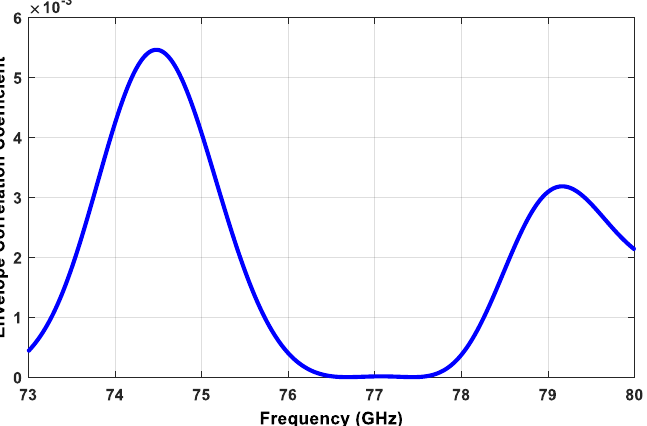
Figure 9. Simulated envelope correlation coefficient of the proposed transmitter subarray configuration.